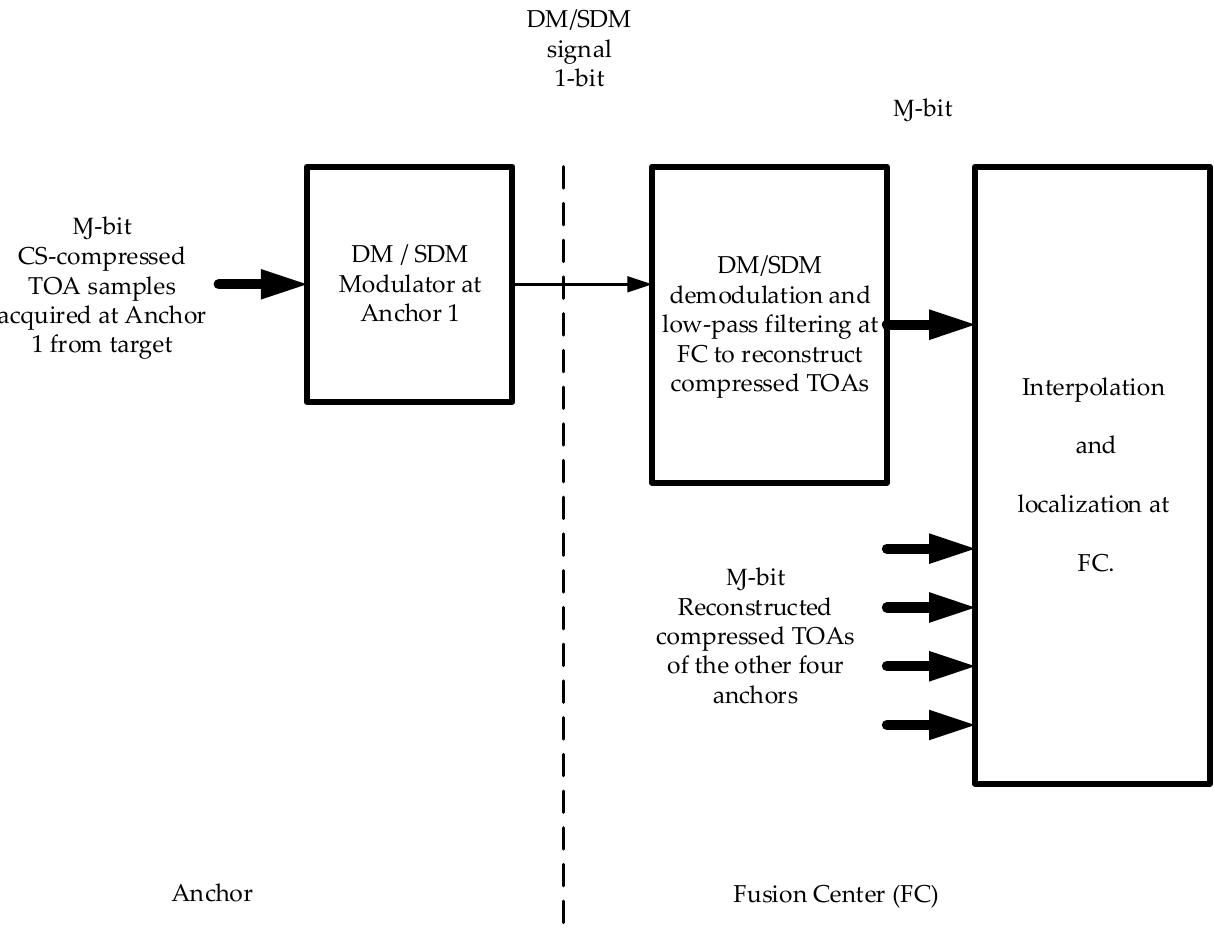
Figure 1. Combined CS-SWL communication-energy-efficient localization wireless sensor system using five anchor or reference nodes. Note that thick arrows are used for multibit connections.